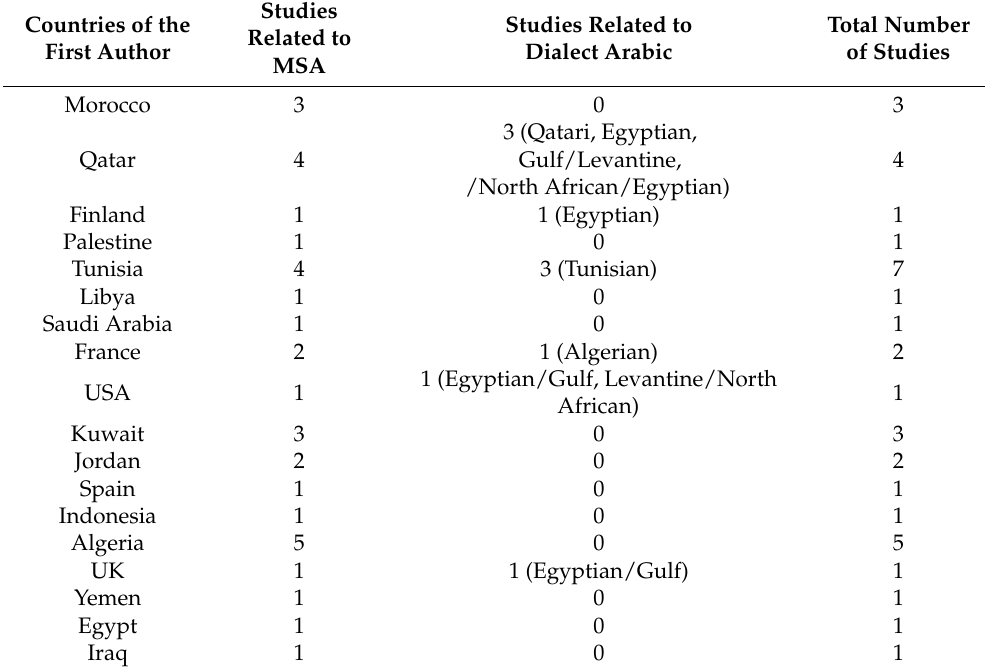
Table 7. The most active countries according to the retained studies. Some studies support more than one type of Arabic. Then, the same study was repeated, which increased the number of studies related to